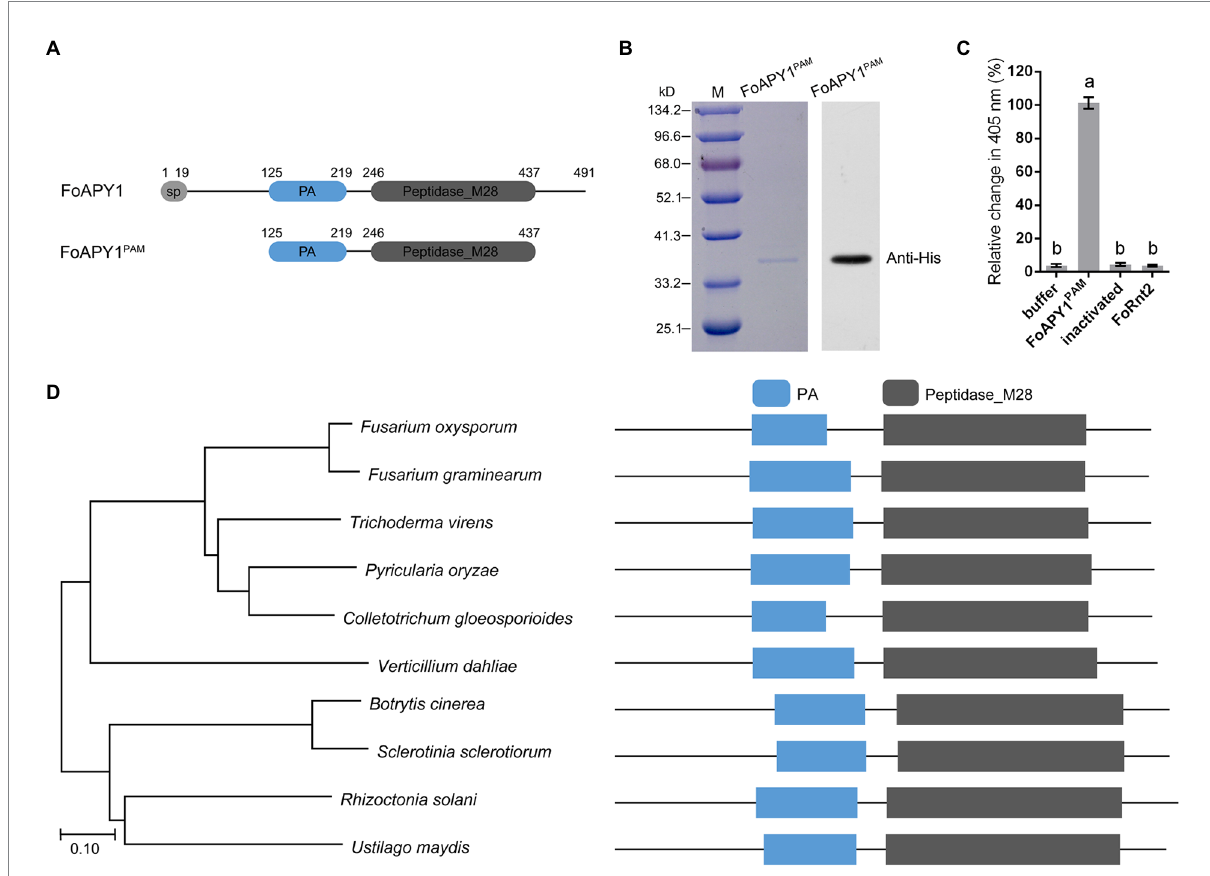
FIGURE 2 FoAPY1 possesses the peptidase activity. (A) Schematic illustration of the FoAPY1 and FoAPY1 PAM proteins. (B) The protein coding sequences were cloned into the pET-28a vector and then expressed in E.coli BL21(DE3). Each protein was incubated with Ni-NTA agarose and then eluted with imidazole. Anti-His was used as the primary antibody in western blotting. (C) Quantification of the change in absorbance at 405 nm. Protein buffer and inactivated FoAPY1 PAM protein were used as negative controls in this experiment. FoRnt2 was used as another negative control and purified from E.coli BL21(DE3) with a His-tag. In the figures, the same letters on the bars mean no significant differences, while the different letters represent significant differences with other groups. (D) Phylogenetic analysis of FoAPY1 and its homologous sequences from B. cinerea (XP_001553683.1), Colletotrichum gloeosporioides (EQB57239.1), Fusarium graminearum (XP_011326156.1), Pyricularia oryzae (ELQ58420.1), Sclerotinia sclerotiorum (XP_001591275.1), Trichoderma virens (UKZ76984.1), Ustilago maydis (XP_011392725.1), Verticillium dahliae (XP_009652286.1) and Rhizoctonia solani (CEL55661.1). The all protein domain was predicted by using Pfam database